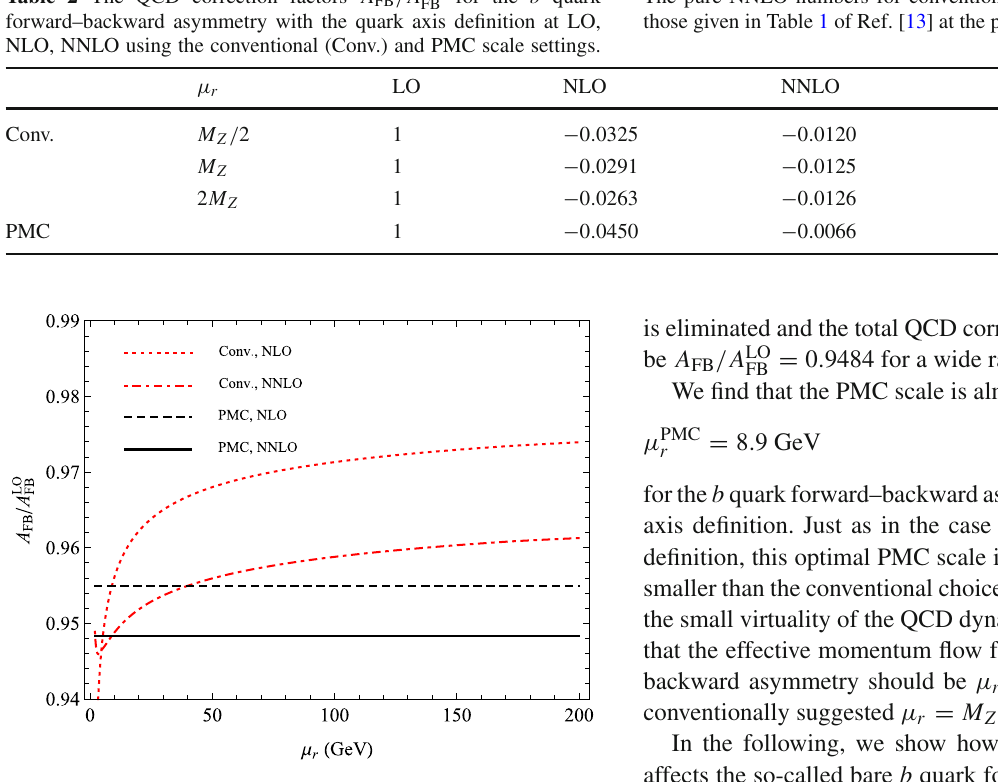
for the b quark The pure NNLO numbers for conventional scale settings agree with FB those given in Table 1 of Ref. [13] at the percent level